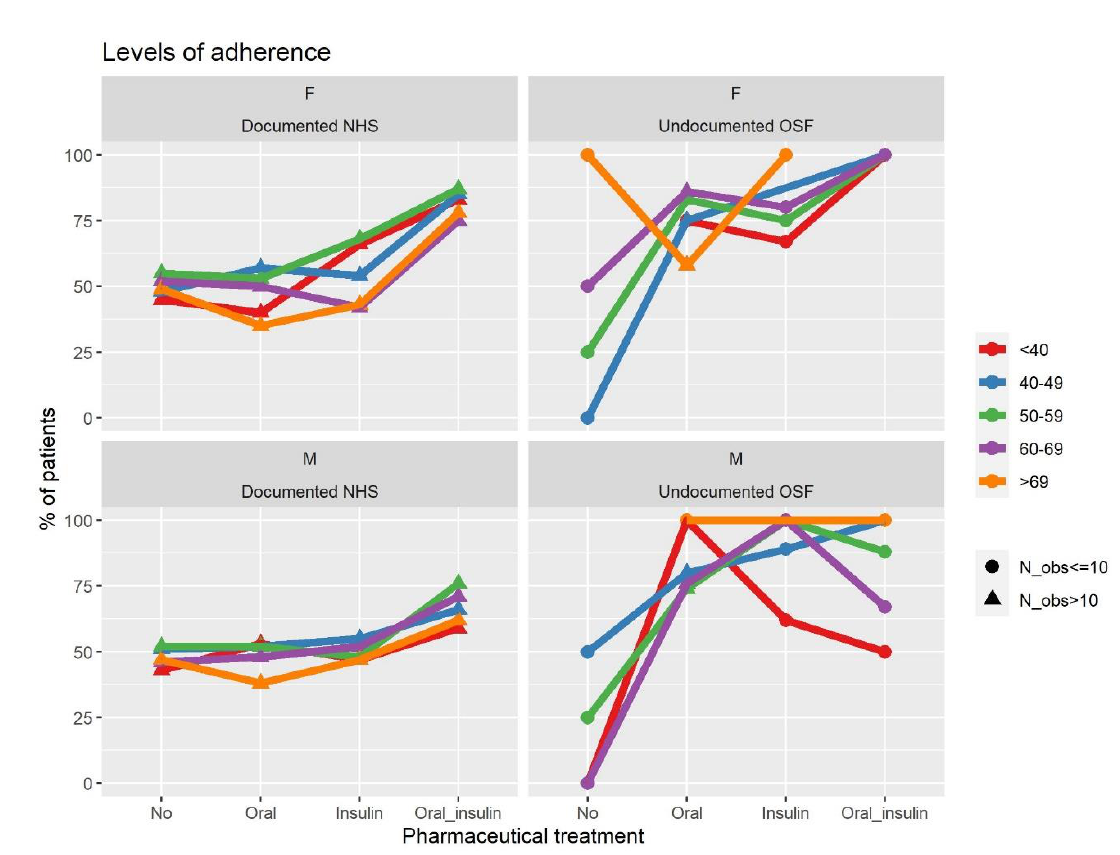
Figure A1. Adherence by sex, age class and therapy, divided for the groups Undocumented OSF and Documented NHS.